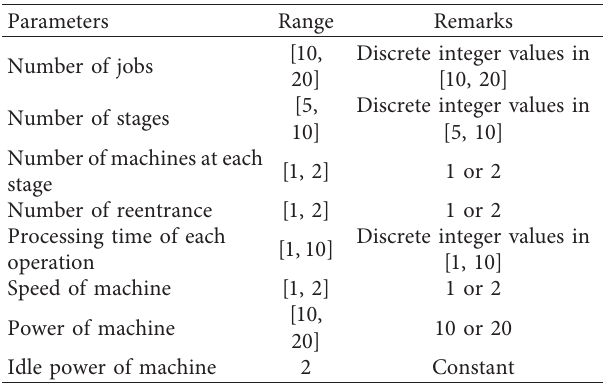
Table 3: Parameter settings.